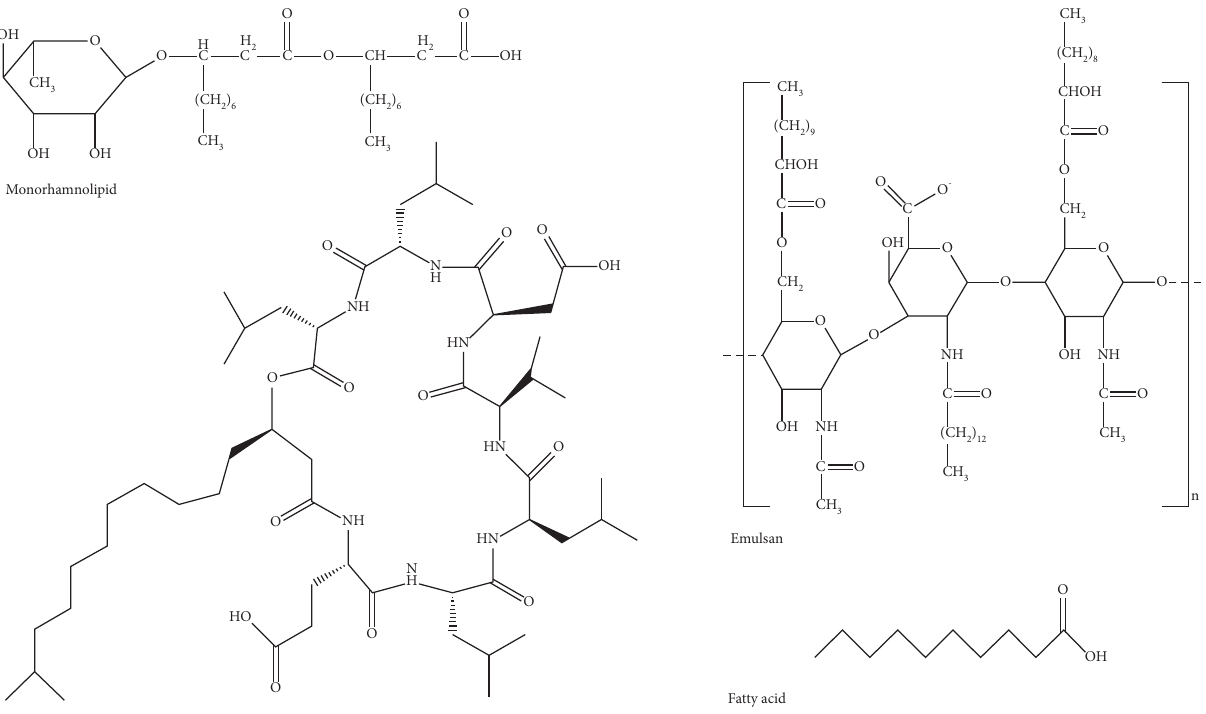
Figure 3: Structural diversity of some common biosurfactants. ∗ Structures are designed with the aid of the Chemdraw